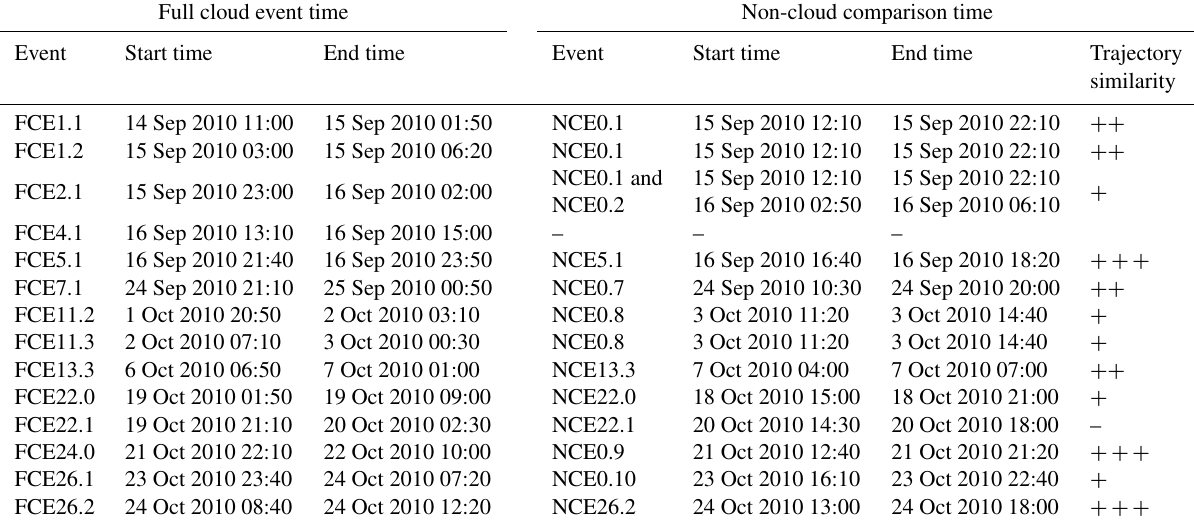
Table 1. Cloud events as defined in Tilgner et al. (2014), and adjacent time periods of non-cloud conditions, defined in the present study. FCE indicates full cloud event, NCE indicates non-cloud event. All times are given in local time. The similarity between the trajectories for cloud events and non-cloud comparison times is given in the last column ( +++ : same air mass trajectories, ++ : small deviations, + : large deviations, − : different air mass